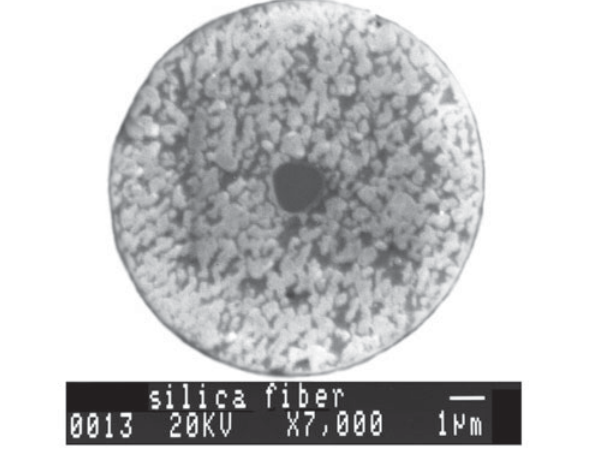
Figure 2. SEM microscopy of transversal polished fiber showing the ceramic phase (white) and the metal phase (dark) with the co- continuous morphology.